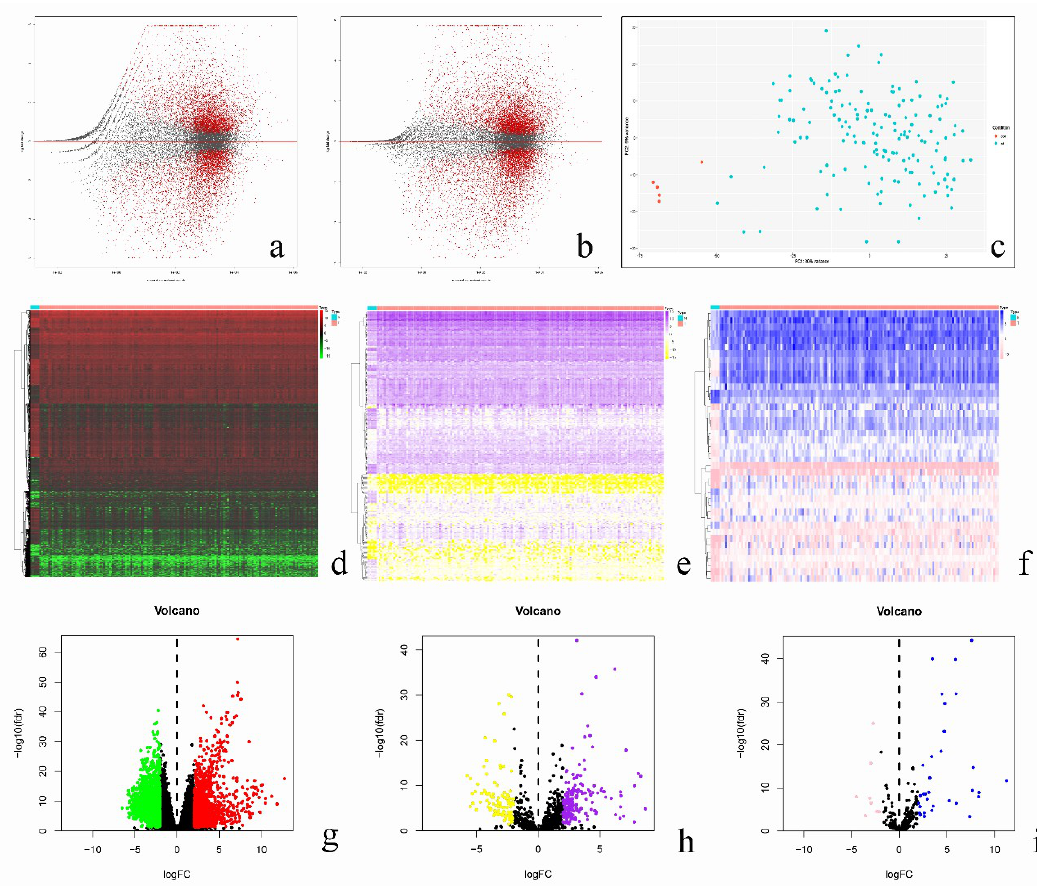
Figure 1. Processing and analysis of 161 glioblastoma (GBM) samples from the TCGA (The Cancer Genome Atlas) database ( a – c ). The heatmap and the volcano plot of 2942 di ff erentially expressed genes among 161 GBM samples ( d , g ). The heatmap and the volcano plot of 291 immune-related genes obtained from ImmPort database after the intersection with di ff erentially expressed genes ( e , h ). The heatmap and the volcano plot of 41 immune-related transcription factors obtained from Cistrome after the intersection with di ff erentially expressed genes ( f , i ). For high-resolution images, see Figures S1–S9.